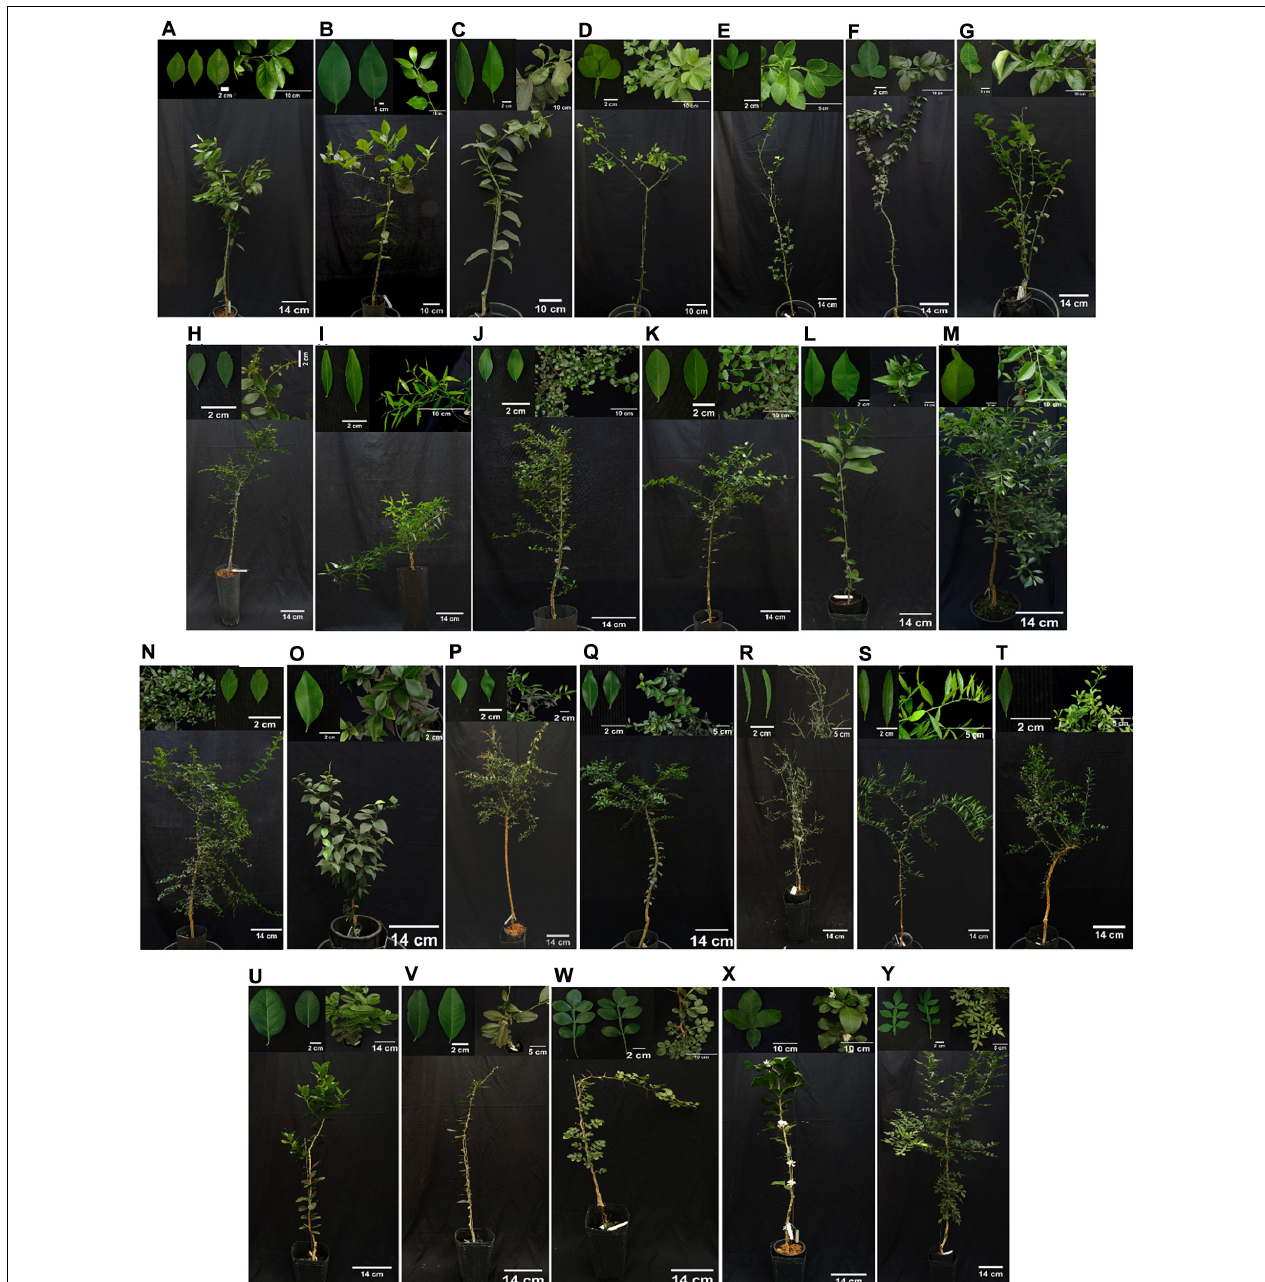
FIGURE 1 | Representative photographs of each of the selected Citrinae genotypes/accessions [cross-compatible (A–T) ; and cross-incompatible, putative graft-compatible (U–Y) with Citrus about 1 year after grafting onto ‘Rangpur’ lime rootstock]. (A) Citrus × sinensis ‘Pera’; (B) C. × sinensis ‘Tobias’; (C) C. halimii; (D) Poncirus trifoliata ‘Pomeroy’; (E) P. trifoliata ‘Benecke’; (F) P. trifoliata ‘Barnes’; (G) P. trifoliata ‘Rubidoux’; (H) Microcitrus australasica; (I) M. australasica ‘Sanguinea’; (J) M. australasica ‘True Sanguinea’; (K) ‘Faustrimedin’ hybrid; (L) M. inodora; (M) M. warburgiana; (N) M. papuana; (O) M. australis; (P) M. virgata hybrid; (Q) Microcitrus sp. × E. glauca hybrid; (R) Eremocitrus glauca; (S) E. glauca × C. × sinensis hybrid; (T) E. glauca × Microcitrus sp. hybrid; (U) Atalantia citroides ; (V) A. ceylanica ; (W) Limonia acidissima ; (X) Citropsis gilletiana ; (Y) Naringi crenulata